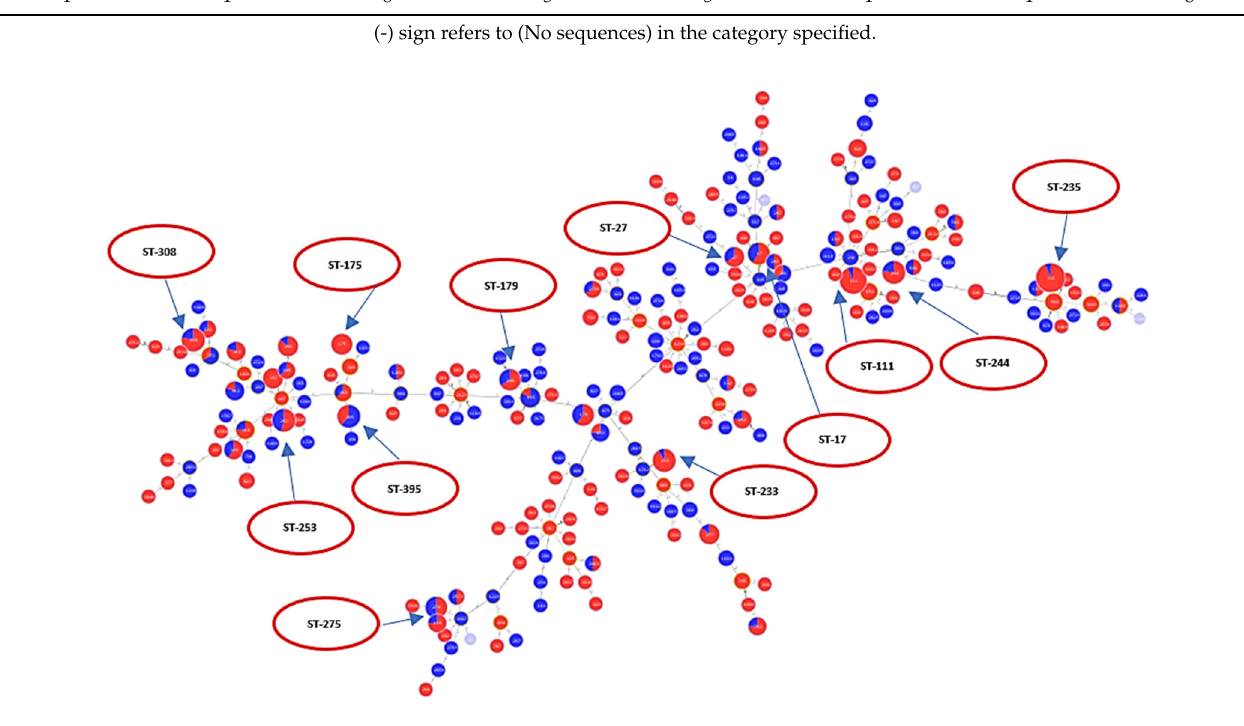
Figure 3. Minimum spanning tree (MST) diagram showing distribution of levofloxacin susceptibility in relation to different STs. Red color: levofloxacin-resistant ( n = 338); blue color: levofloxacin-susceptible ( n = 190). A chi-square test for independence (with Yates’ continuity correction) indicated sig-